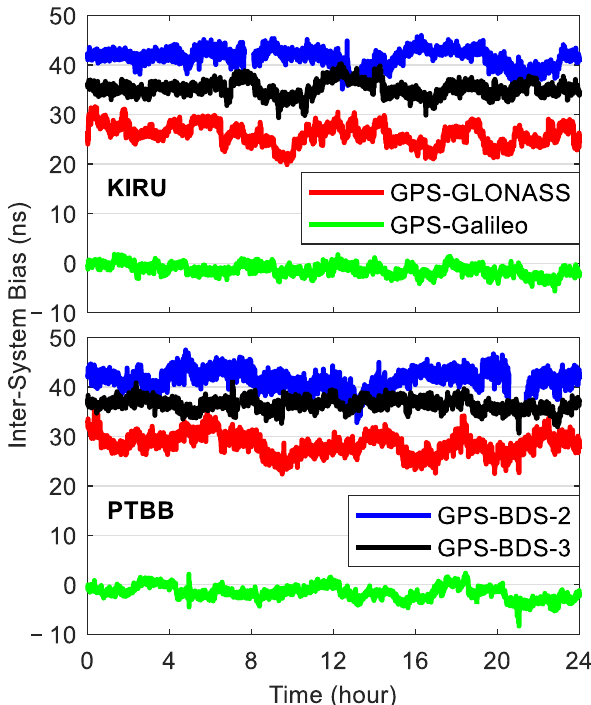
Figure 2. Epochwise ISB estimates at stations KIRU and PTBB on DOY 41 of 2020.